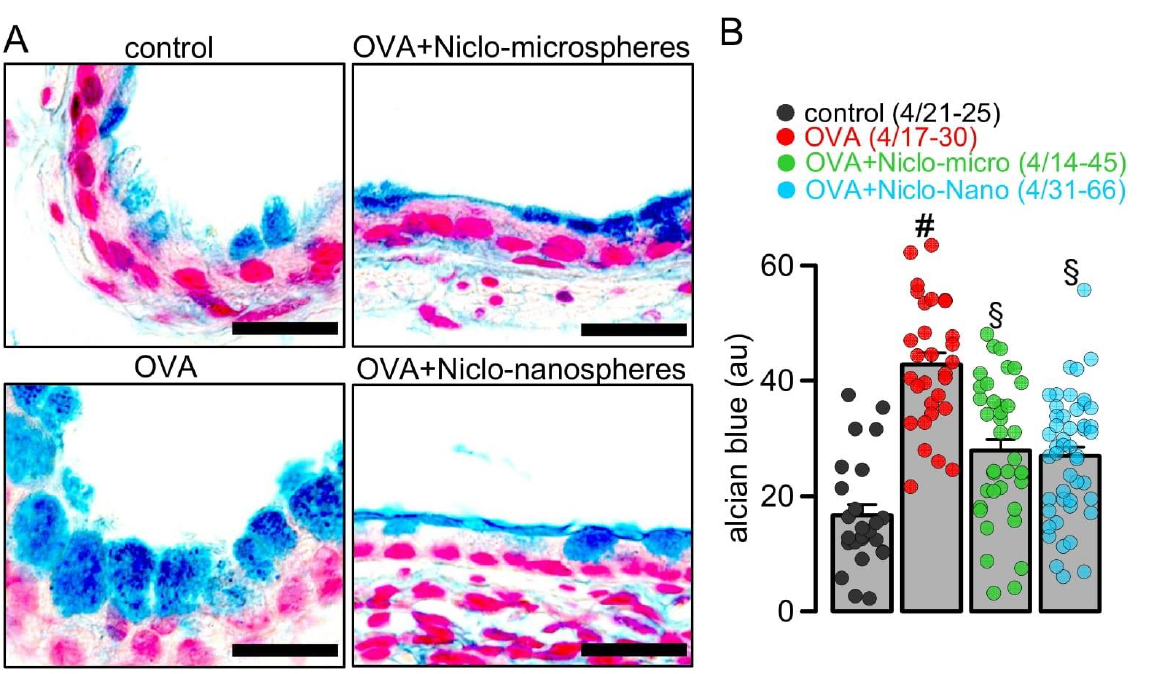
Figure 1. Inhibition of mucus production by Niclo-spheres of micrometer and nanometer size. ( A ) Airway mucus staining by alcian blue in control mice and asthmatic mice sensitized with ovalbumin (OVA). Intratracheal instillation of niclosamide (Niclo)-loaded microspheres ( 0.98 mg; 30 μM niclosamide) or nanospheres ( 0.196 mg; 30 μM niclosamide) strongly reduced mucus production in bronchi of asthmatic mice. Bar = 50 μm. ( B ) Summary of experiments as shown in ( A ). Mean ± SEM (number of animals/number of bronchi analyzed). # significant difference from control. § significant difference from OVA ( p < 0.05, ANOVA).